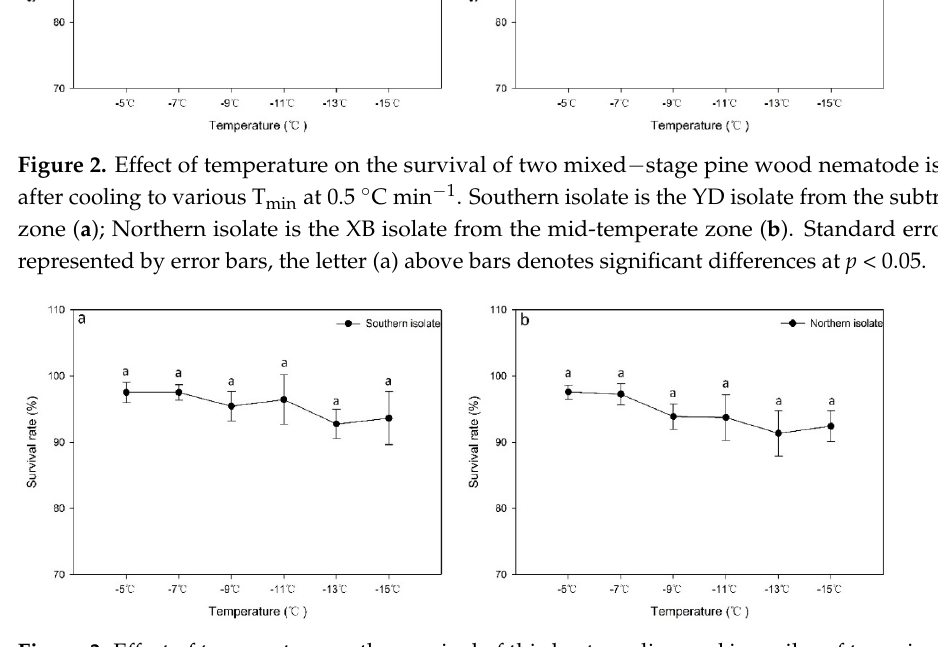
Figure 3. Effect of temperature on the survival of third − stage dispersal juveniles of two pine wood nematode isolates after cooling to various T min at 0.5 °C min − 1 . Southern isolate is the YD isolate from the subtropical zone ( a ); Northern isolate is the XB isolate from the mid-temperate zone ( b ). Standard errors are represented by error bars, the letter (a) above bars denotes significant differences at p < 0.05.